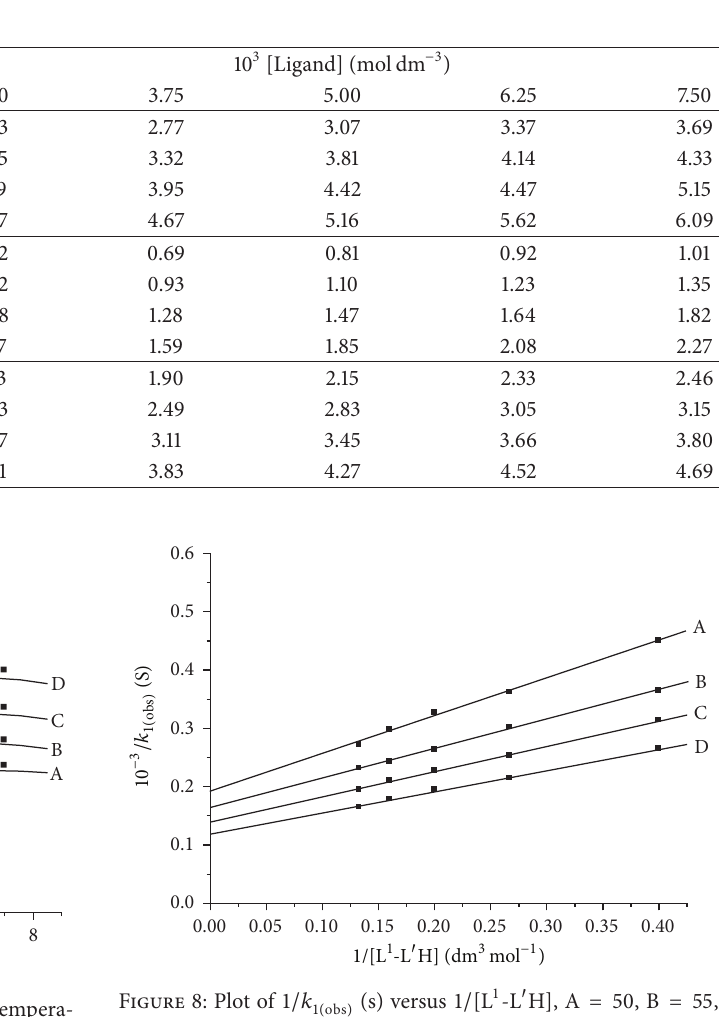
Figure 7: Plots of 𝑘 1( (s −1 ) versus [ L 1 -L 󸀠 H ] at different tempera- obs ) tures, A = 50 , B = 55 , C = 60 , and D = 65 ∘ C.